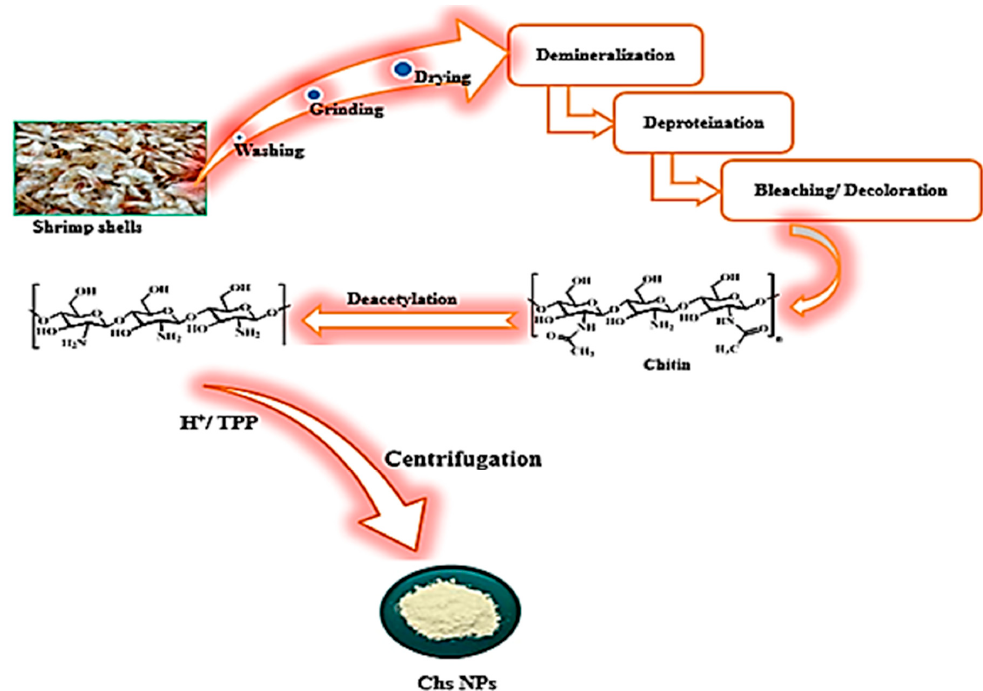
Figure 1. Schematic representation for the extraction of Chs NPs from the shrimp shells.